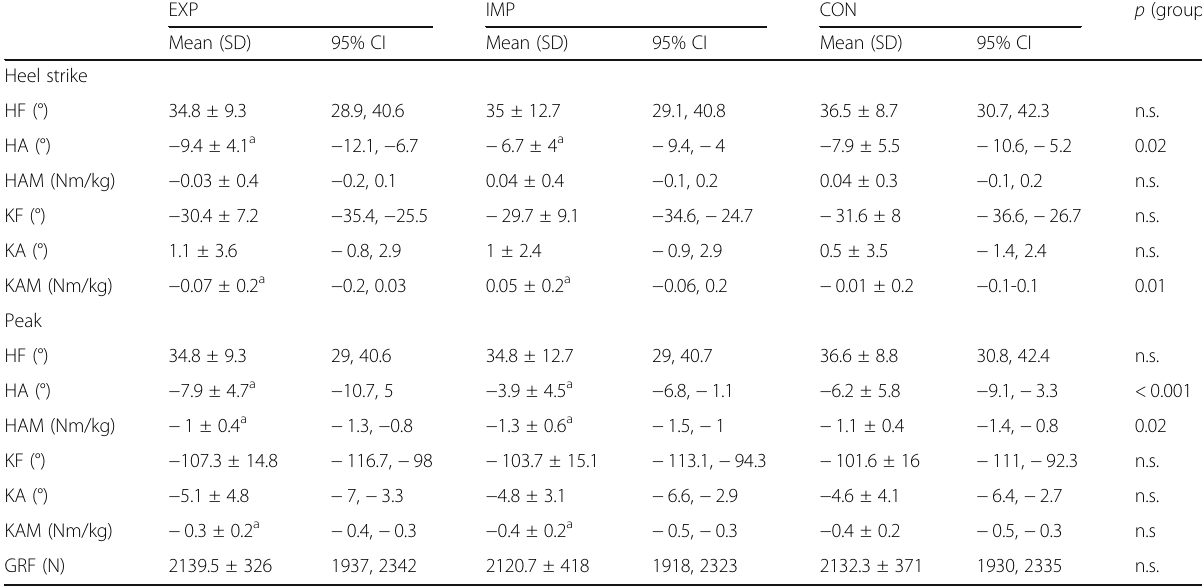
Table 5 Descriptive statistics for group main effect for all dependent measures at initial contact and peak